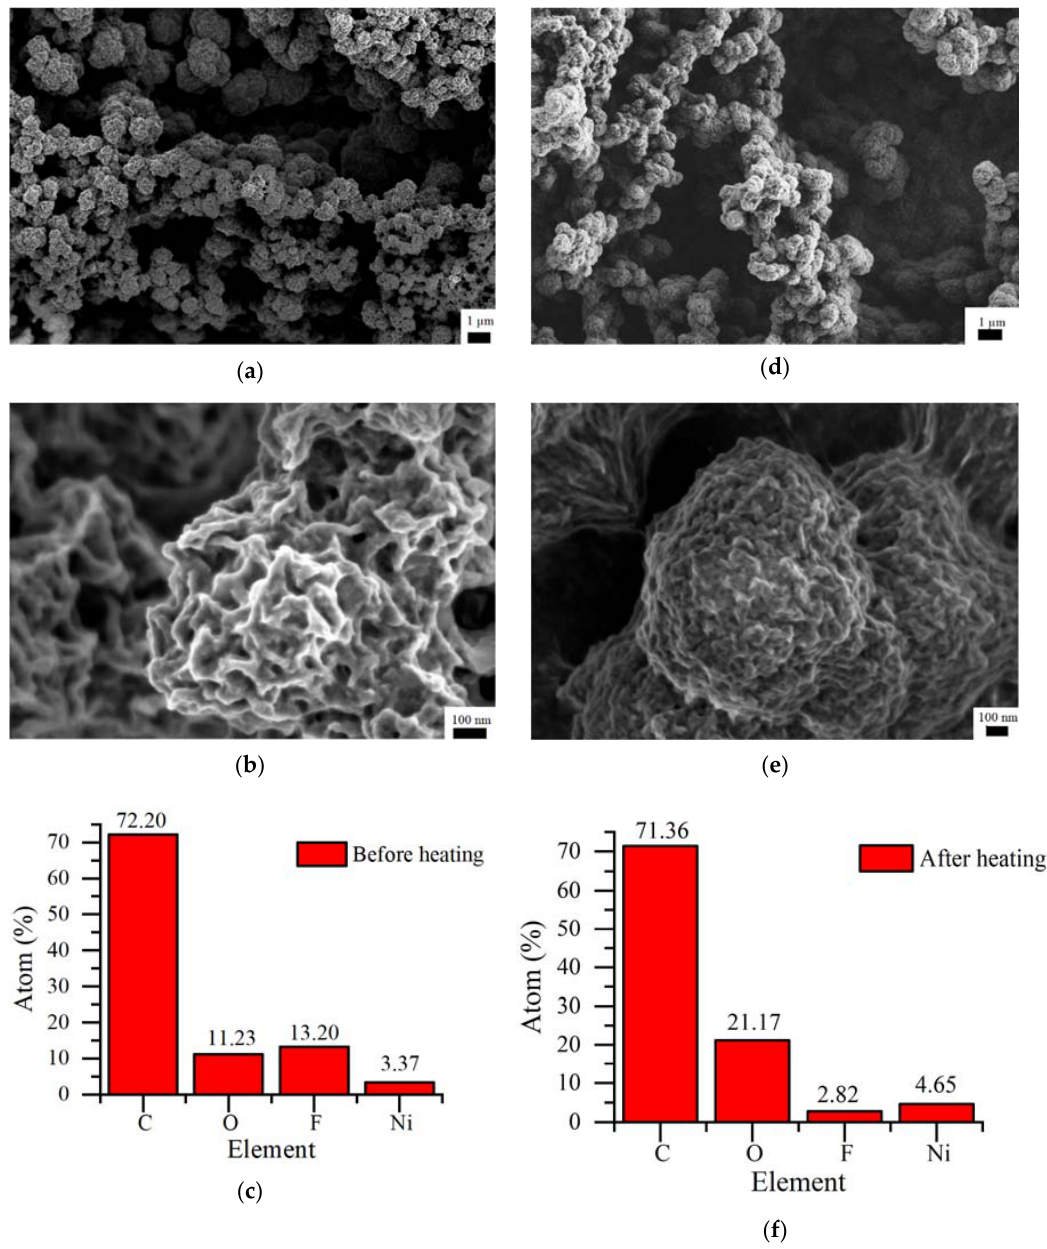
Figure 5. SEM/EDX results of the same samples, recorded before heating ( a , b , c ) and after heating to Figure 5. SEM / EDX results of the same samples, recorded before heating ( a – c ) and after heating to the the temperature of 250 °C ( d , e , f ). temperature of 250 ◦ C ( d – f